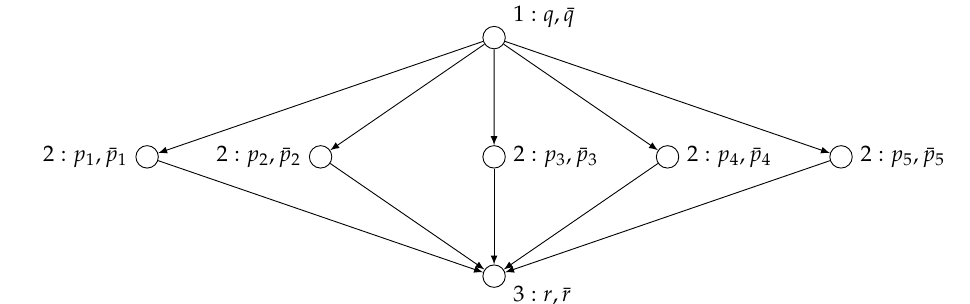
Figure 12. Construction of the DAG for the coNP-hardness proof for FIT FOR BACKWARDS INDUCTION in the case of the formula ϕ being defined over five variables p 1 through p 5